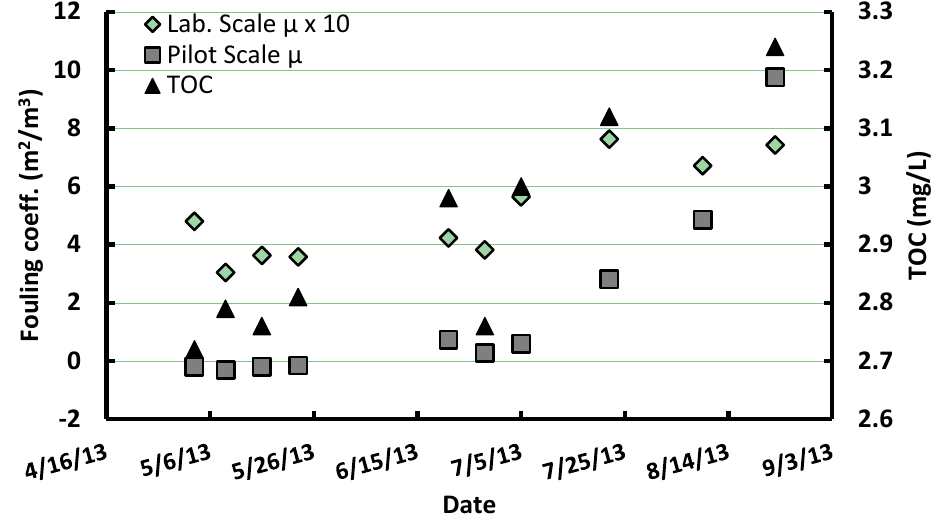
Figure 2. Comparison of lab-scale (1 fiber) and pilot polymeric membrane (w/o pretreatment) total fouling coefficients along with settled water Total Organic Carbon (TOC) concentration variations from May to September 2013.